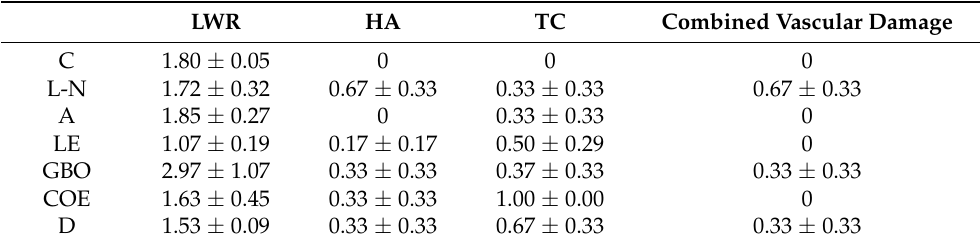
Table 5. Histopathological results of the kidney.